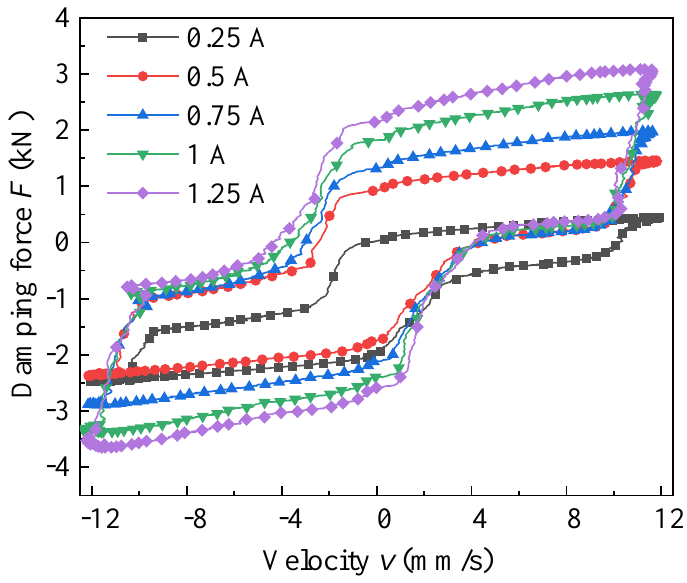
Figure 29. Damping force under different velocities. Figure 30 shows the damping force under different amplitudes at the frequency of 0.25 Hz and current of 0.5 A. It can be concluded that the damping force exhibits enhancement with the augmentation of the displacement amplitude. The reason is that the piston velocity increases with the increase of the displacement amplitude at a settled frequency. The maximum experimental damping force is 2.7 kN at amplitude of 10 mm. Figure 31 shows the damping force under different frequencies at the amplitude of 7.5 mm and current of 0.5 A. Due to the increase of frequency, the fluid flow rate in the system increases, which lead to the increasing of the viscous pressure drop, and the output damping force increases too. Moreover, the maximum damping force gently reaches 3.5 kN at the frequency of 1